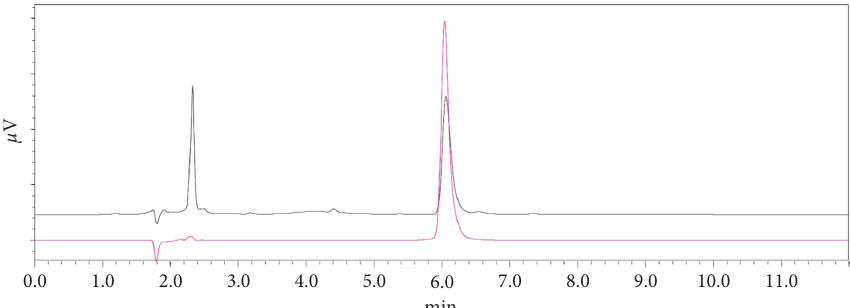
Figure 4: Typical chromatogram for the degraded levamisole standard with 0.5M NaOH ( : intact drug; : degraded drug).